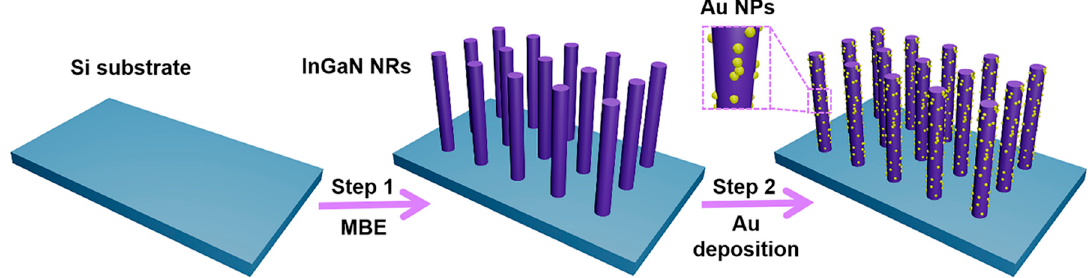
Figure 1. Schematic diagram of the preparation process for decoration of Au nanoparticles (NPs) on InGaN nanorod (NR) arrays.